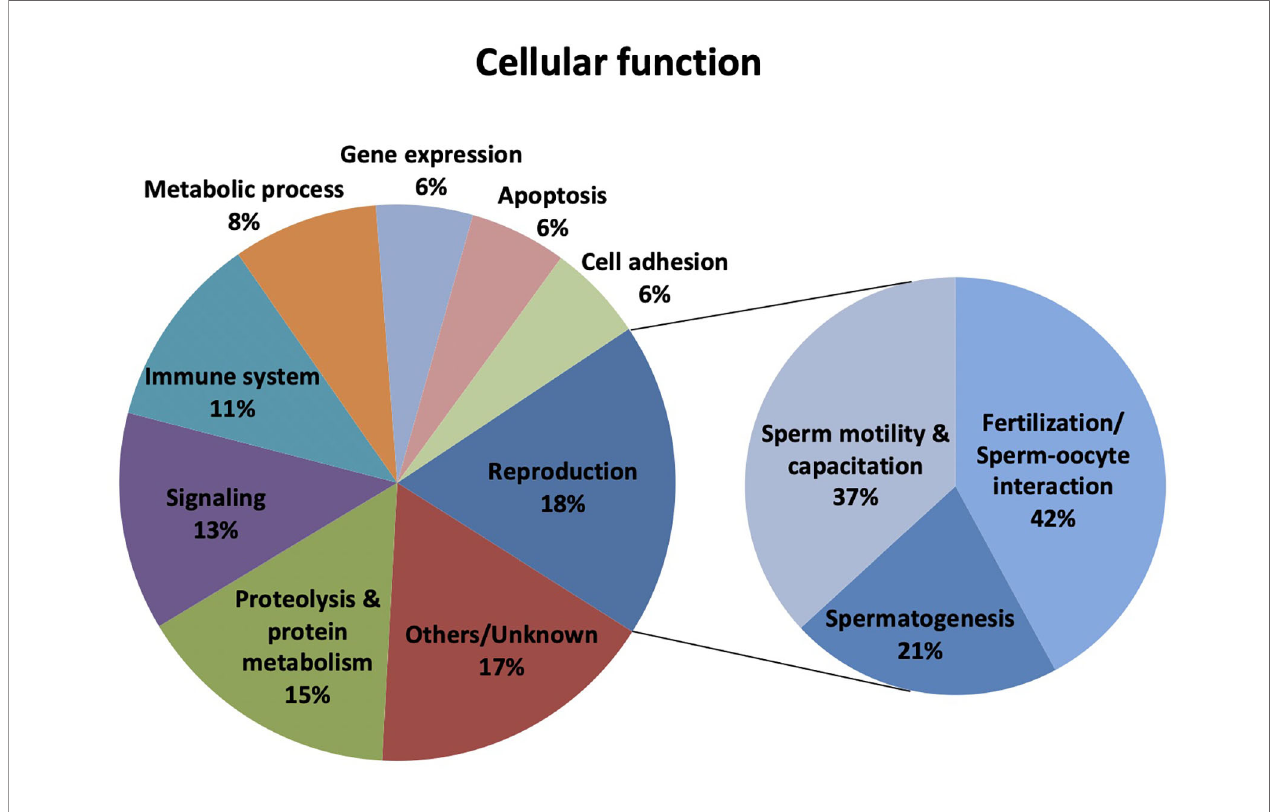
FIGURE 1 | Classi fi cation of the differentially expressed sperm proteins in male hypogonadism (n=43) according to their Cellular function. Protein classi fi cation was made according to UniProtKB/Swiss-Prot database